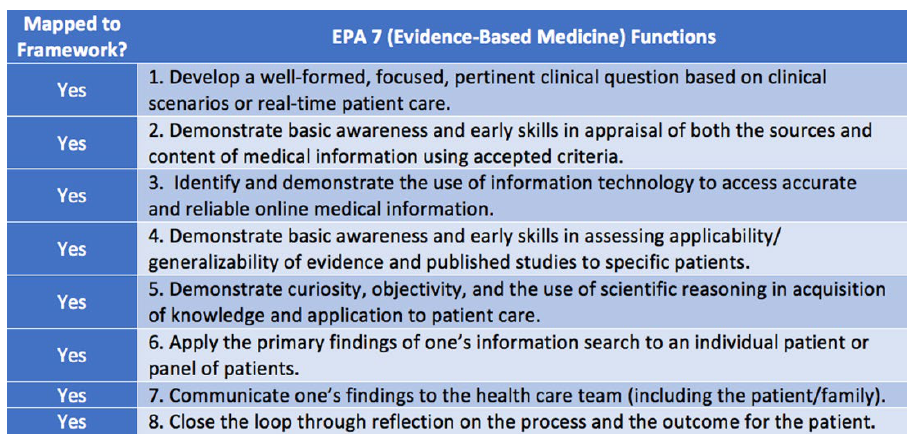
Figure 1 Core Entrustable Professional Activity (EPA) 7 mapped to the Association of College & Research Libraries (ACRL)